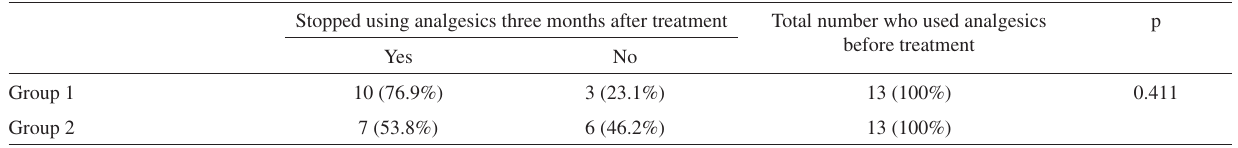
Fisher’s exact test - p > 0.5